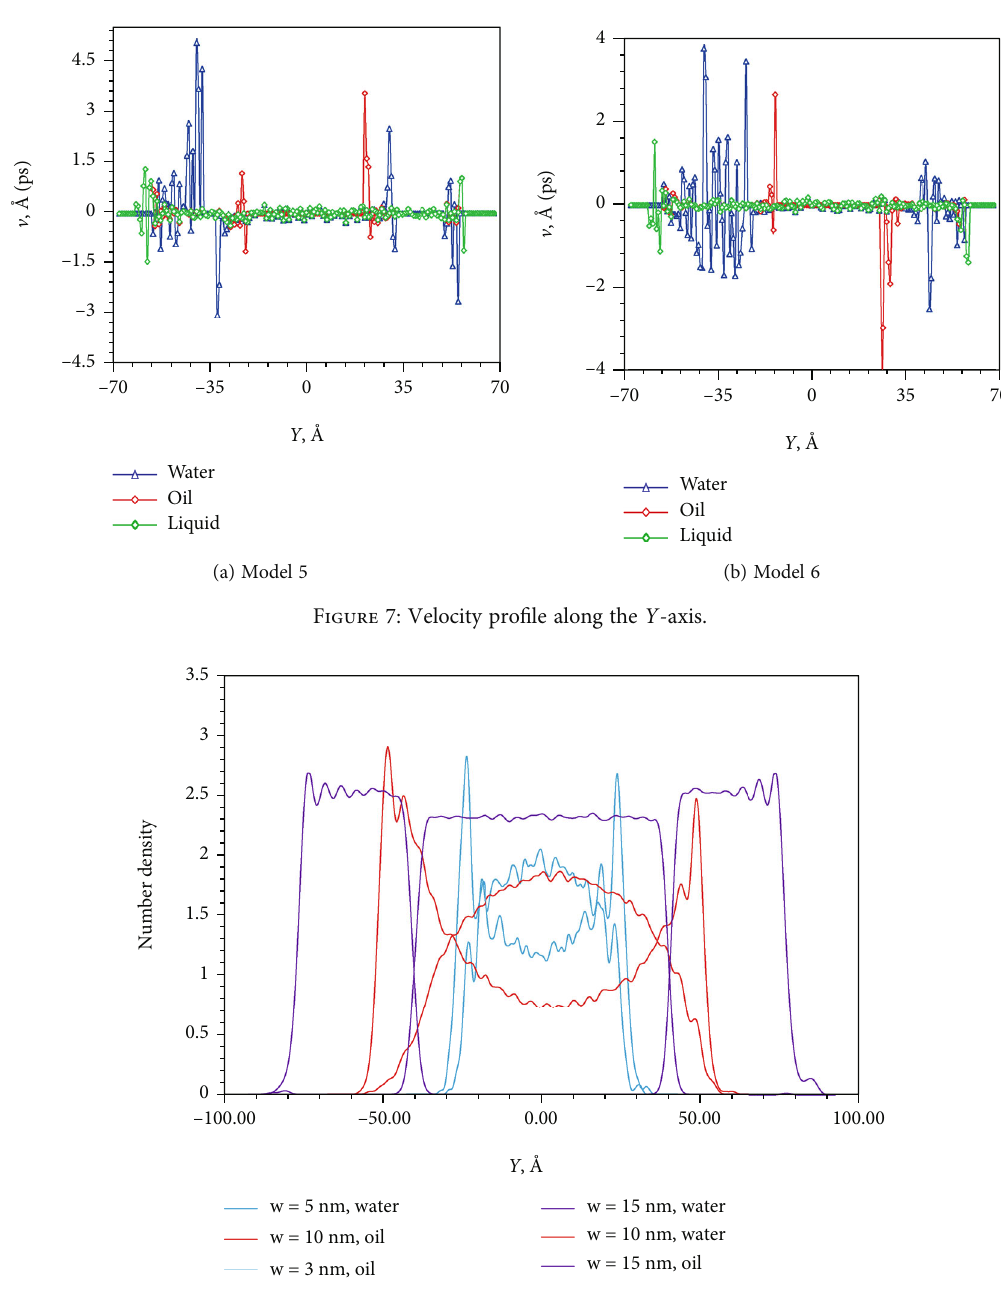
Figure 8: Number density of di ff erent beads.